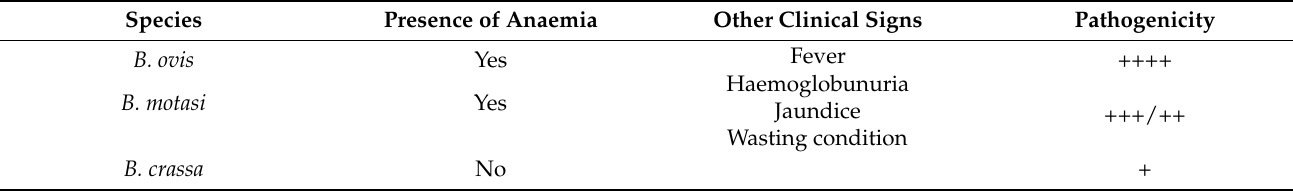
Table 1. Clinical signs associated with each Babesia